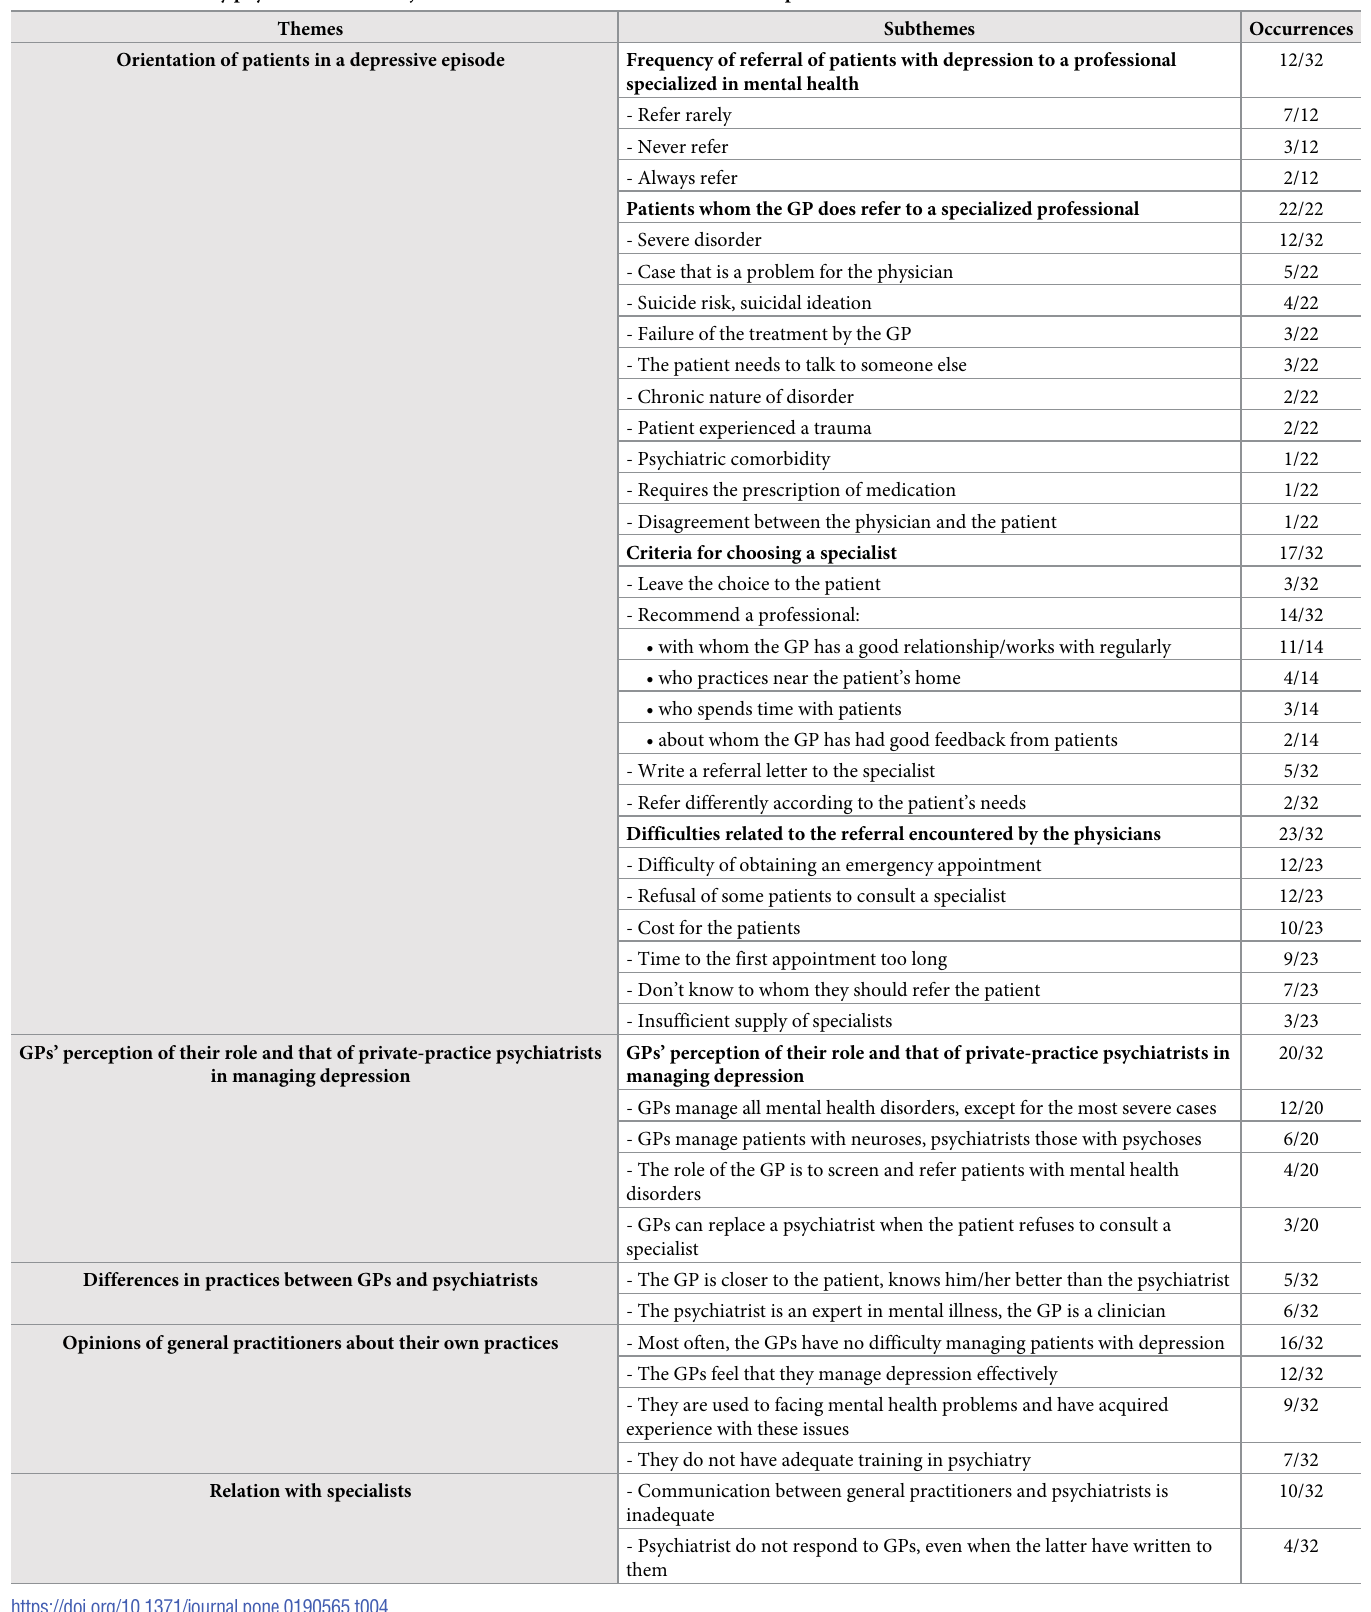
Table 4. Themes raised by physicians on the subject of their collaboration with mental health